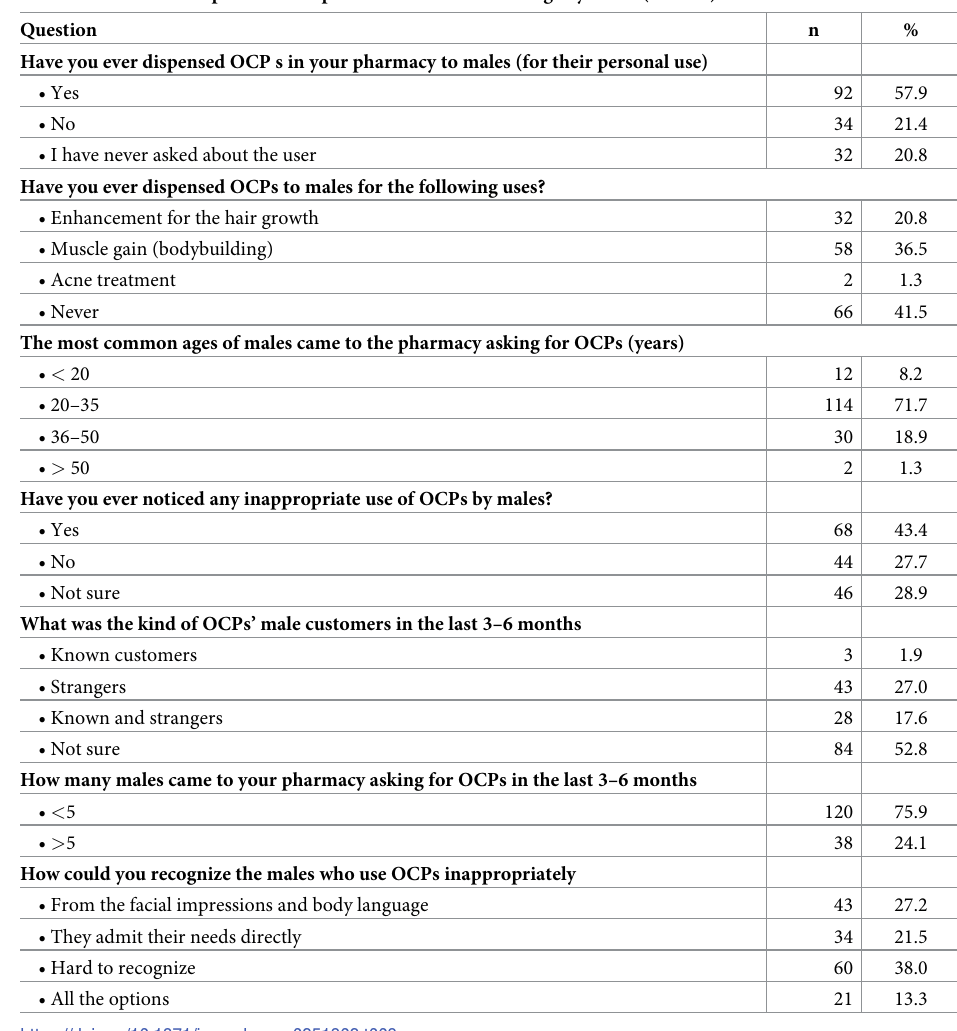
Table 3. Pharmacist experience and practice towards OCPs usage by males (n =